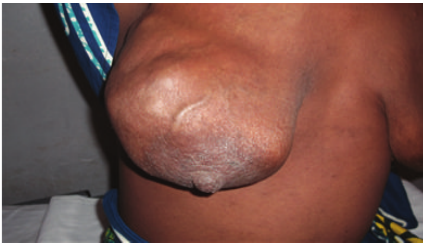
Figure 1: Multilobed mass of the right breast in a young woman of 40 years infected with HIV.